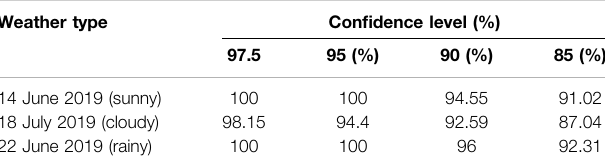
TABLE 5 | Coverage rate of con fi dence